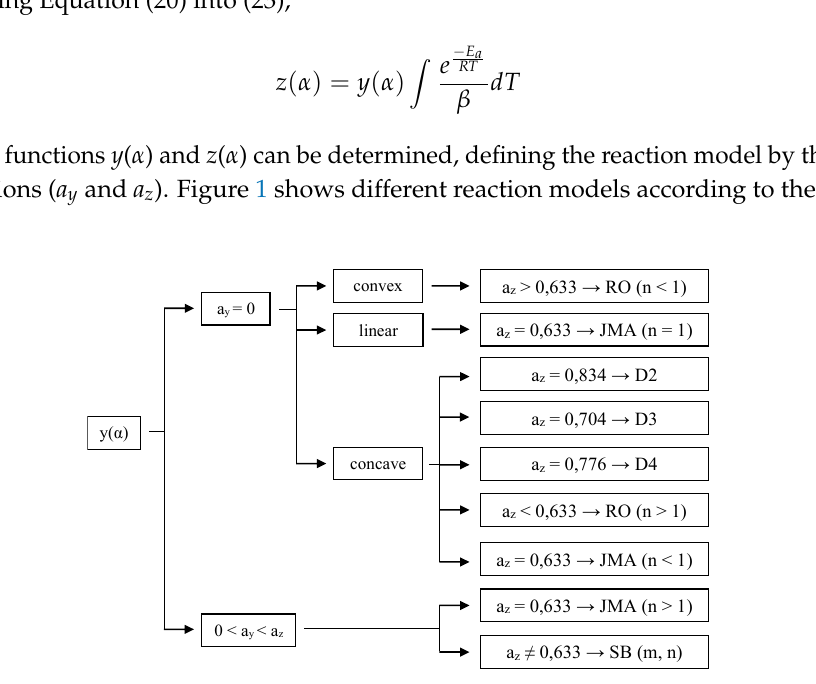
Figure 1. Schematic diagram of kinetic models using y ( α ) and z ( α ) functions (Adapted from [33,34]).